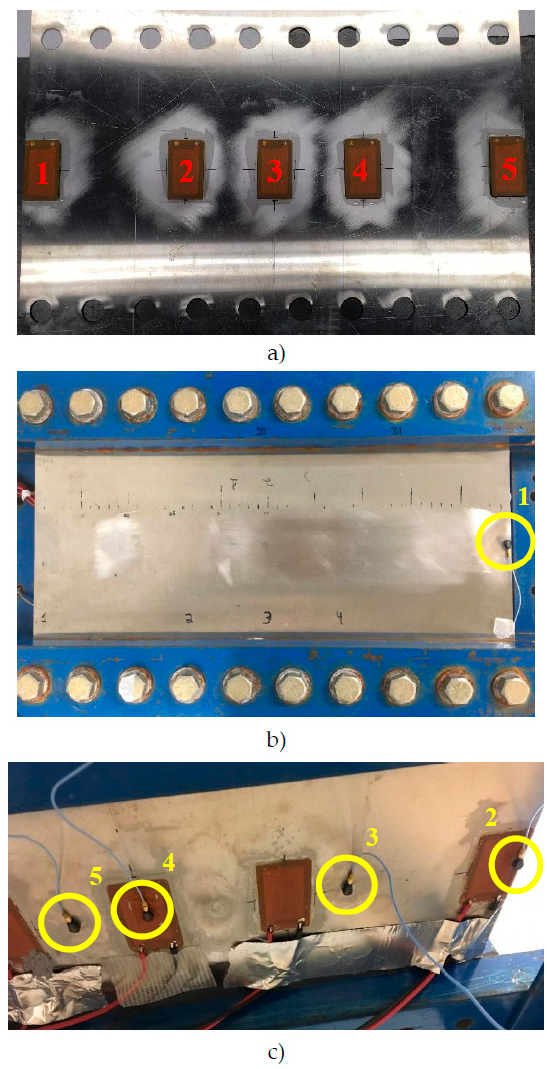
Figure 3. Actuator positions ( a ) flat plate setup from top view with accelerometer 1 ( b ) and from bottom view with positions of accelerometers 2 to 5 ( c ). view with positions of accelerometers 2 to 5 ( c